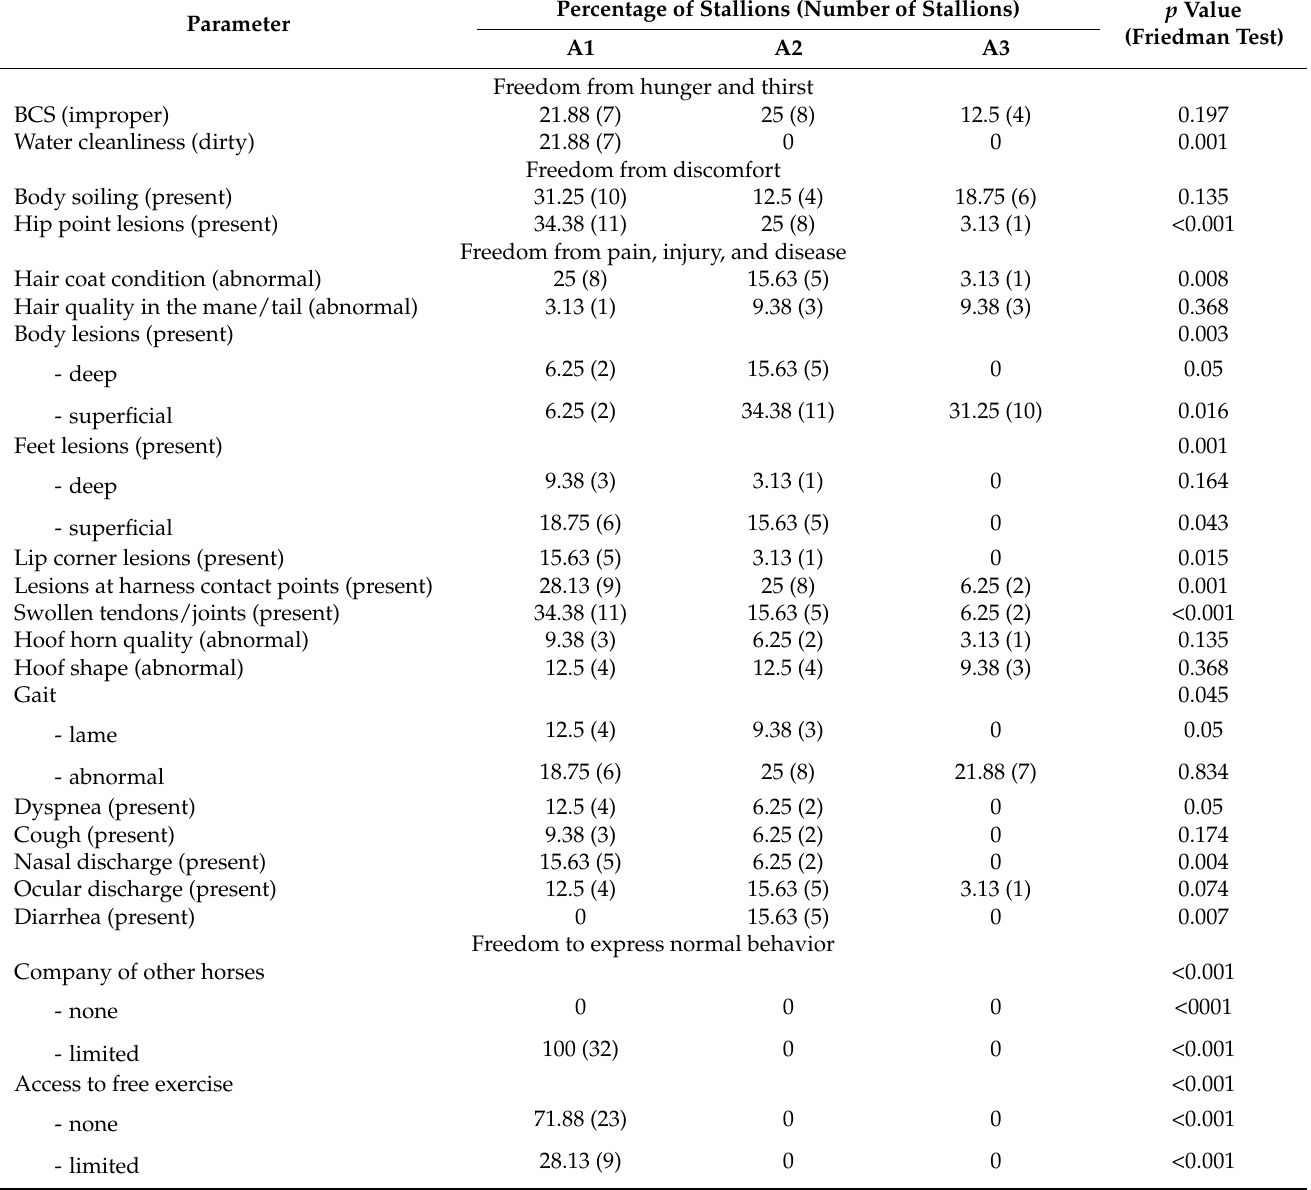
Table 3. Results for the welfare parameters (improper) of the stallions in each of the three assessments and the significance of differences between